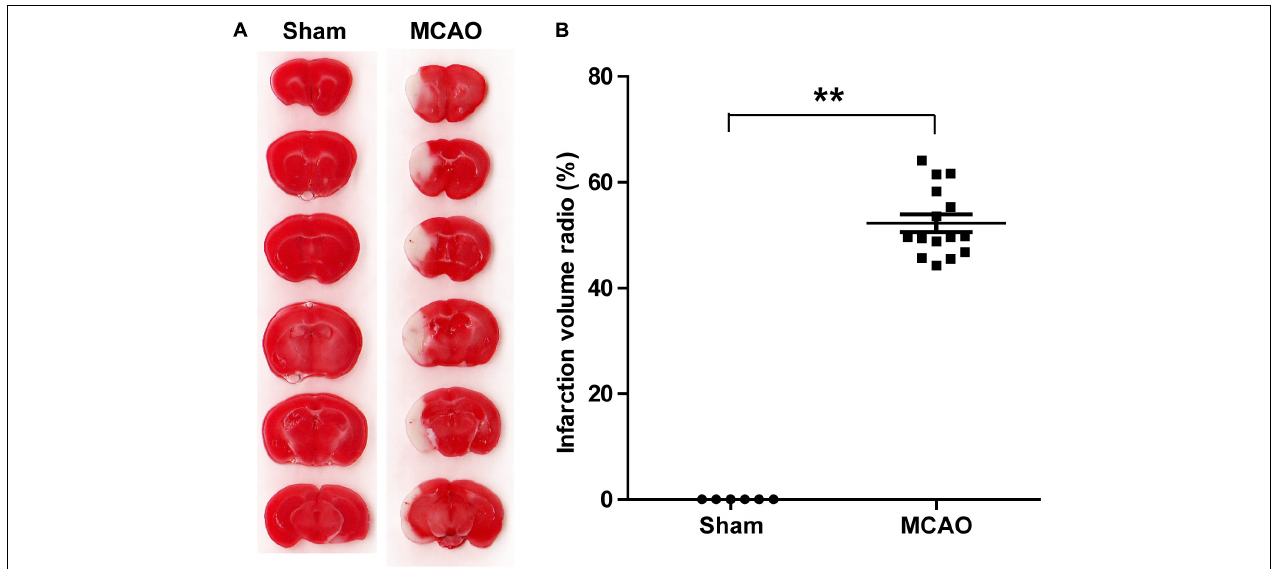
FIGURE 4 | A tMCAO mouse model. (A) A representative image of TTC staining, normal tissues were stained in red, while the infarction area was stained in white. The infarct volume was measured by TTC staining 24 h after the onset of ischemia. (B) The statistical analysis of infarct volume. The infarct volume was 51.24 ± 7.89% in the tMCAO group; sham group, n = 6, tMCAO group, n = 15, ** P < 0.01.